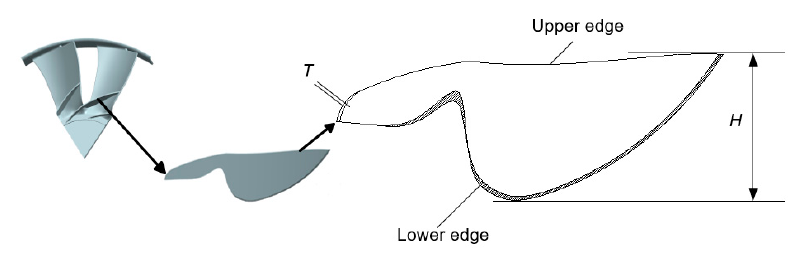
Figure 7. Geometric model of the guiding fi ns.